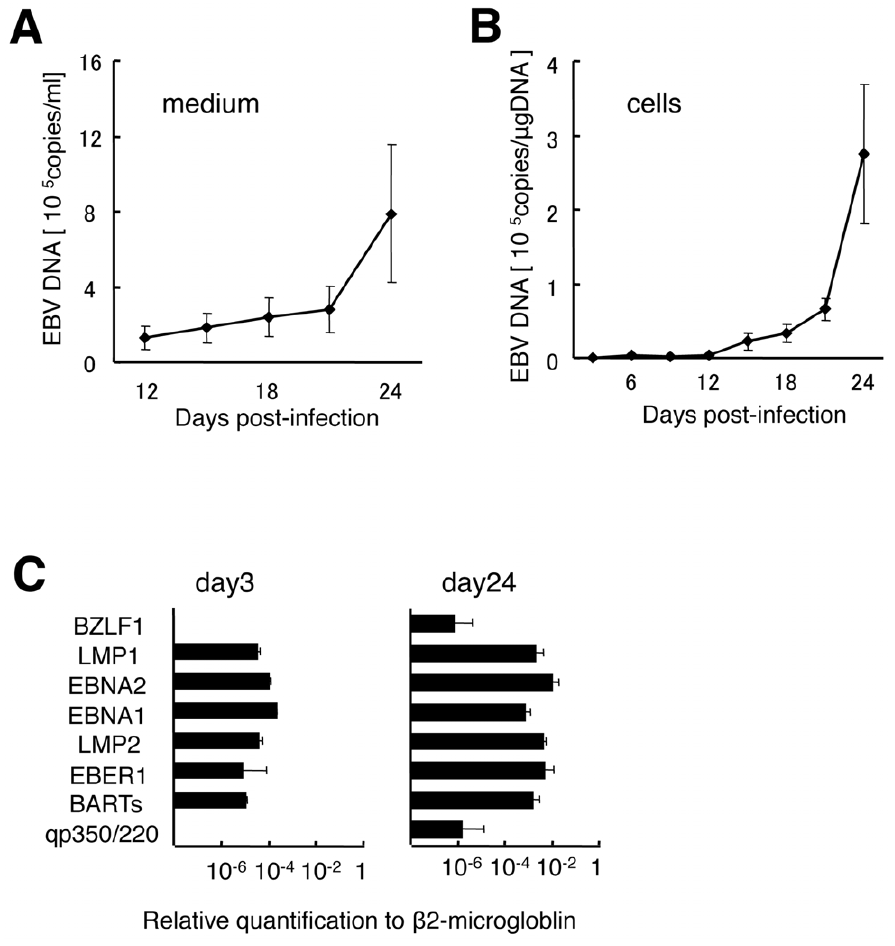
Figure 2. Kinetics of EBV DNA and expression patterns of EBV-related genes in human tonsil tissue explants infected with EGFP- EBV. Cell-free supernatants and cells collected from culture medium were used for quantification of EBV DNA by real-time PCR assay and quantification of viral mRNA by real-time RT-PCR assay. Data are presented as mean 6 standard error of the mean. A ) Plots of accumulated EBV DNA in cell-free culture medium after 12 days post-infection ( n =8). B ) Plots of accumulated EBV DNA in cells from medium ( n =2). C ) Levels of EBV-related genes expressions in cells at 3 and 24 days post-infection ( n =3).